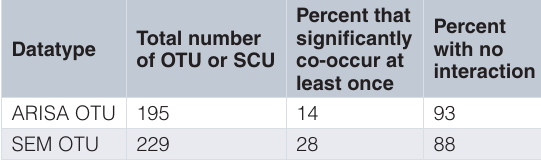
Table 3. Proportion of Co-occurring Pairs within the ARISA and SEM Community